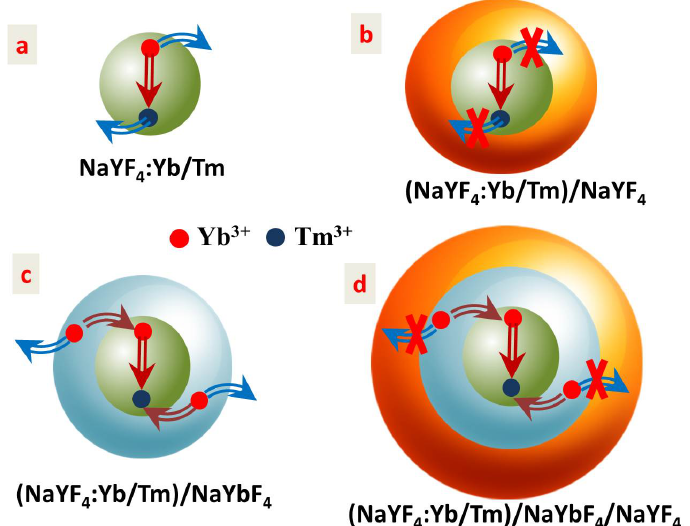
Figure 6. Schematic illustration of the luminescence quenching mechanism in: ( a ) The core NaYF : 30%Yb 3+ , 0.5%Tm 3+ nanoparticles, as well as the luminescence enhancement 4 mechanism in ( b ) The active core/inert shell (NaYF nanoparticles; ( c ) The active core/active shell (NaYF nanoparticles; and ( d ) The active core/active shell/inert shell (NaYF 0.5%Tm 3+ )/NaYbF /NaYF 4 4